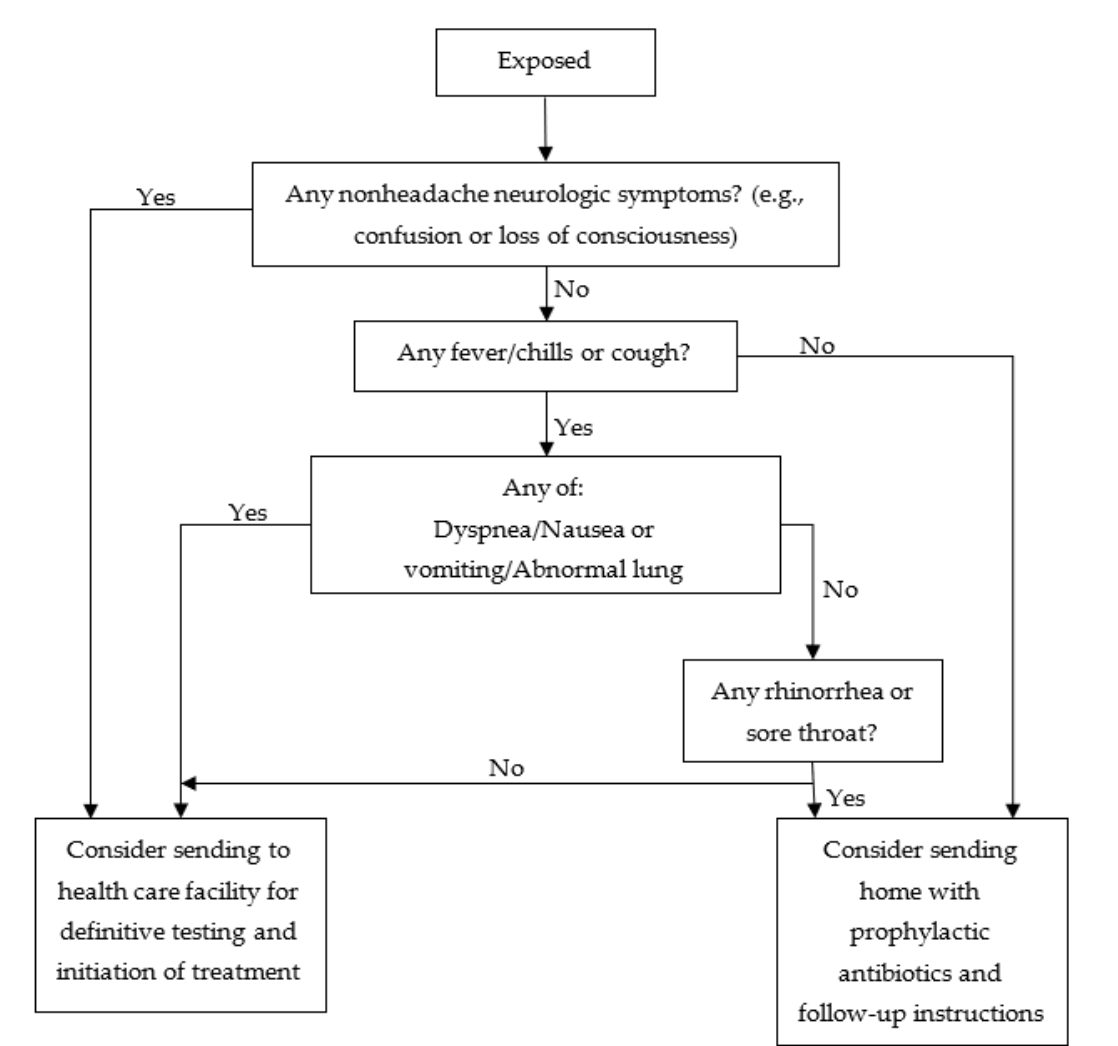
Figure 9. Three-tier screening protocol to identify potential early inhalational anthrax cases in the setting of a large-scale anthrax attack.